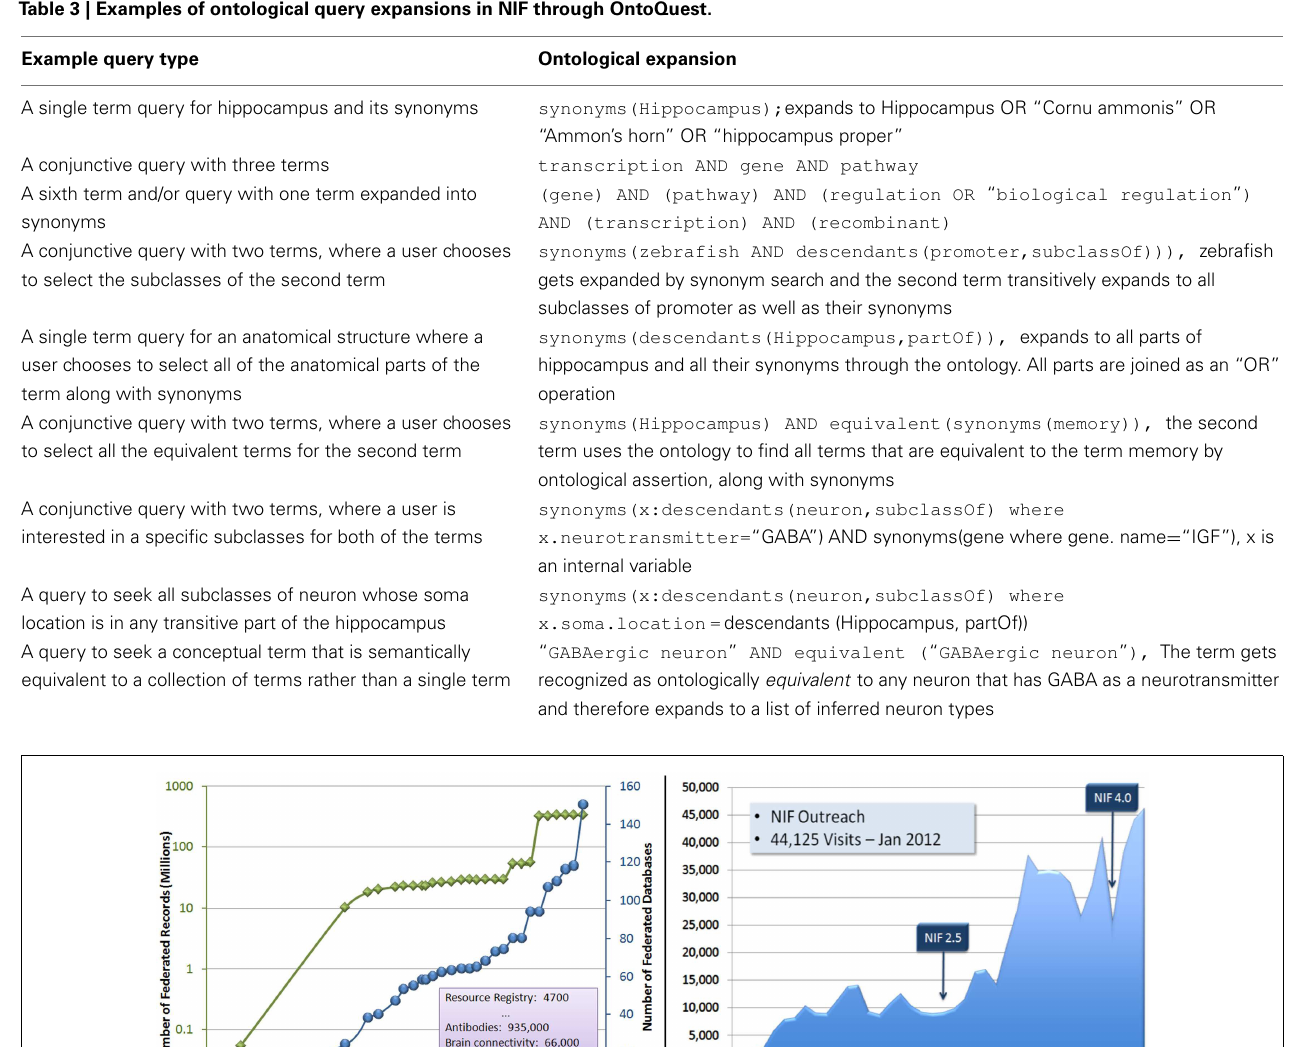
Table 3 | Examples of ontological query expansions in NIF through